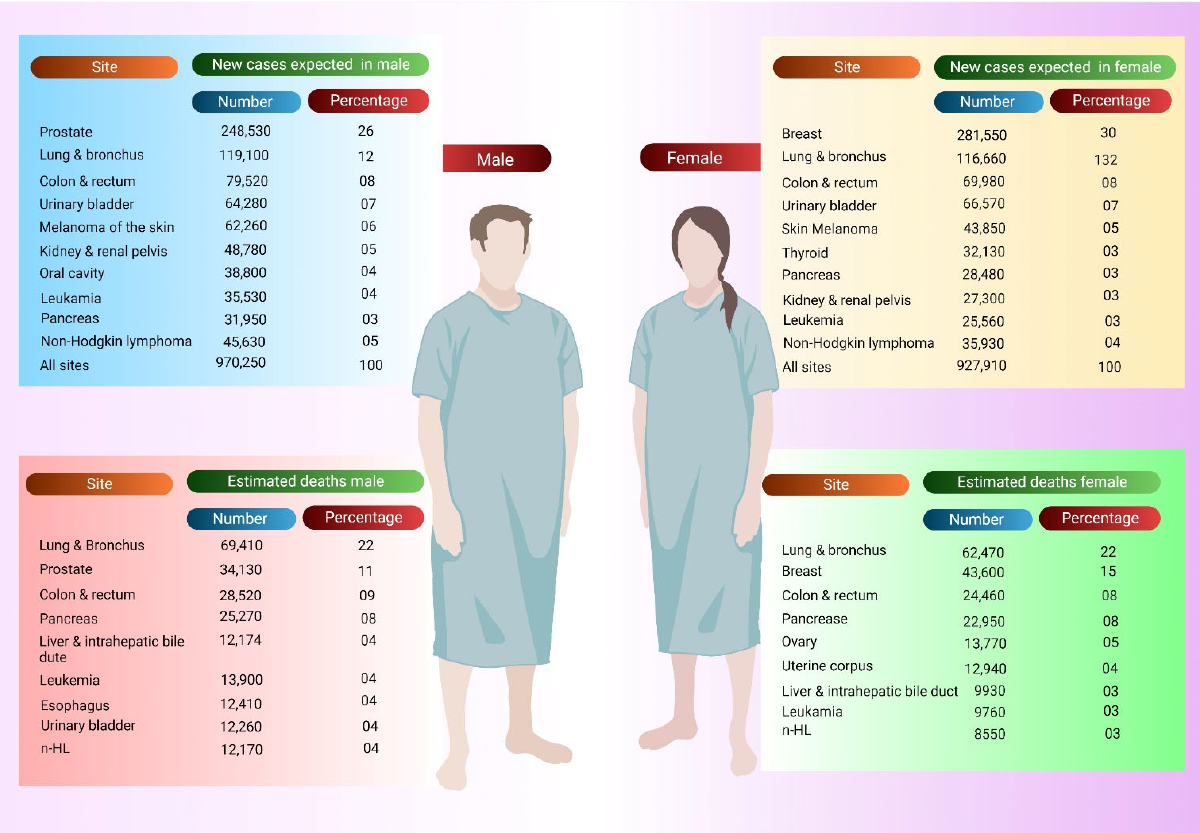
Figure 1. New cancer cases and deaths in the major sites—estimates for 2021 [18].